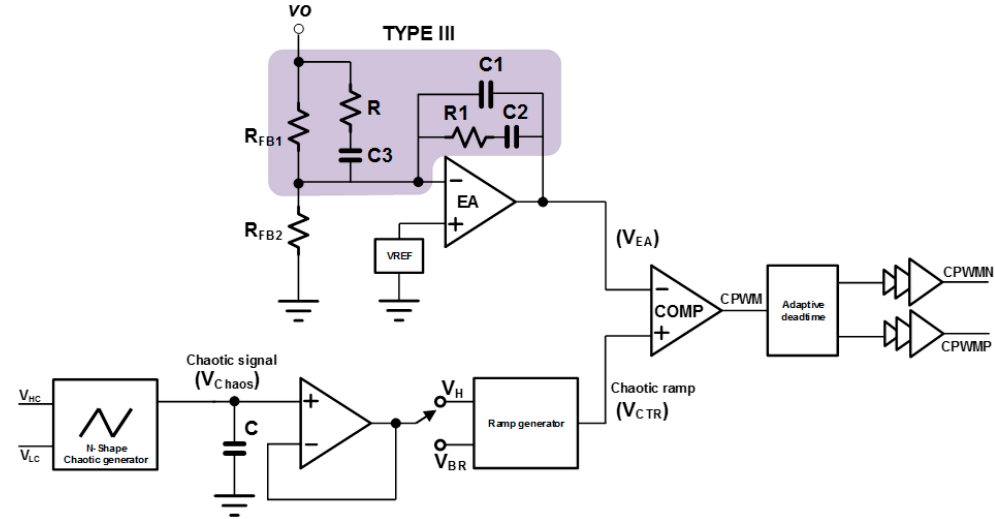
Figure 2. Proposed scheme for synthesizing a chaotic pulse-width modulation (PWM) signal with an N-shaped chaotic generator for a buck converter using a type-III compensator network.